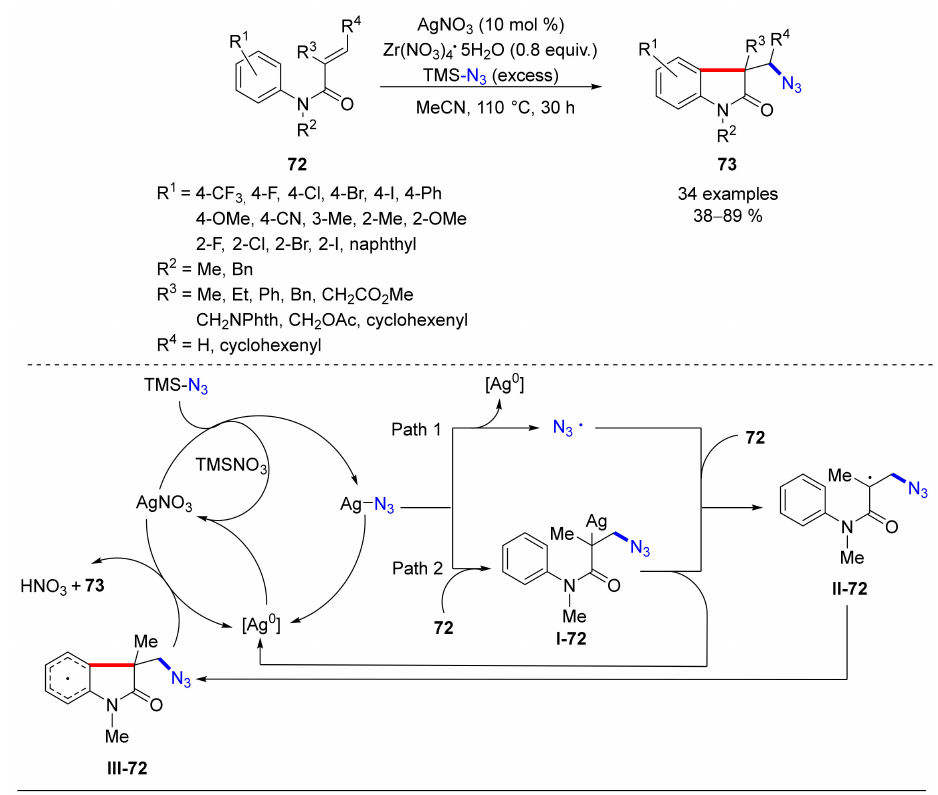
Scheme 72. Radical-silver catalyzed procedure of